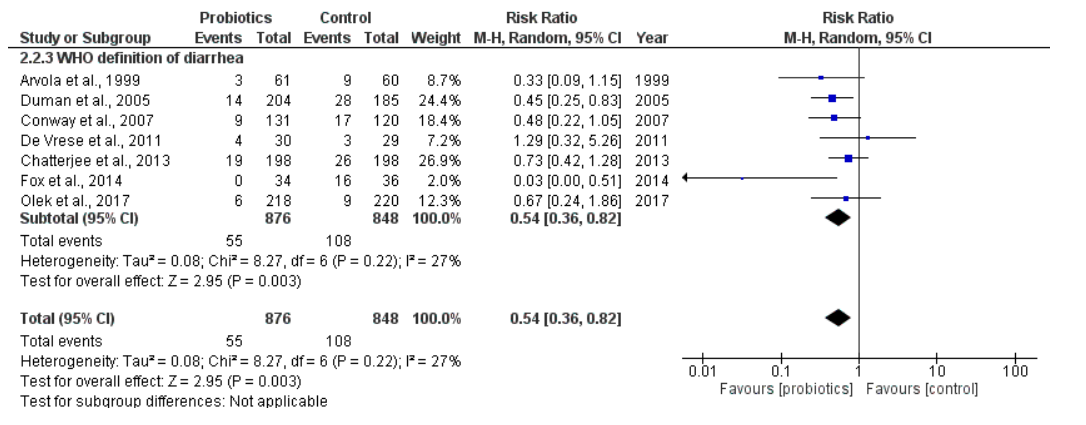
Figure 4. Efficacy results of probiotic use by study (secondary outcome: incidence of AAD using the criteria defined by WHO).